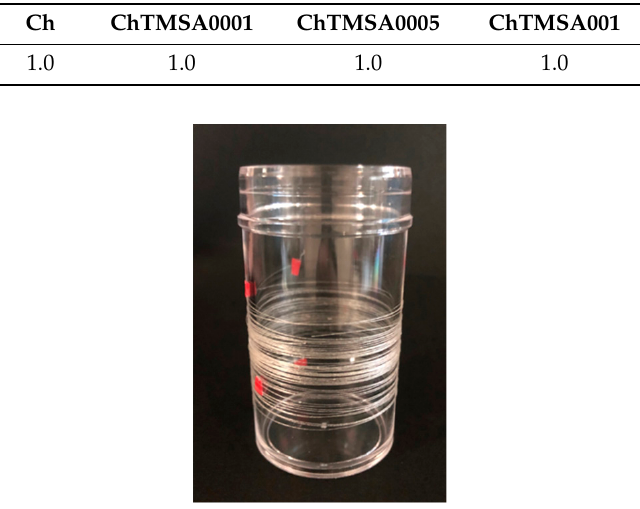
Table 1. The half width values at 2 θ = 20 ◦ from XRD patterns.